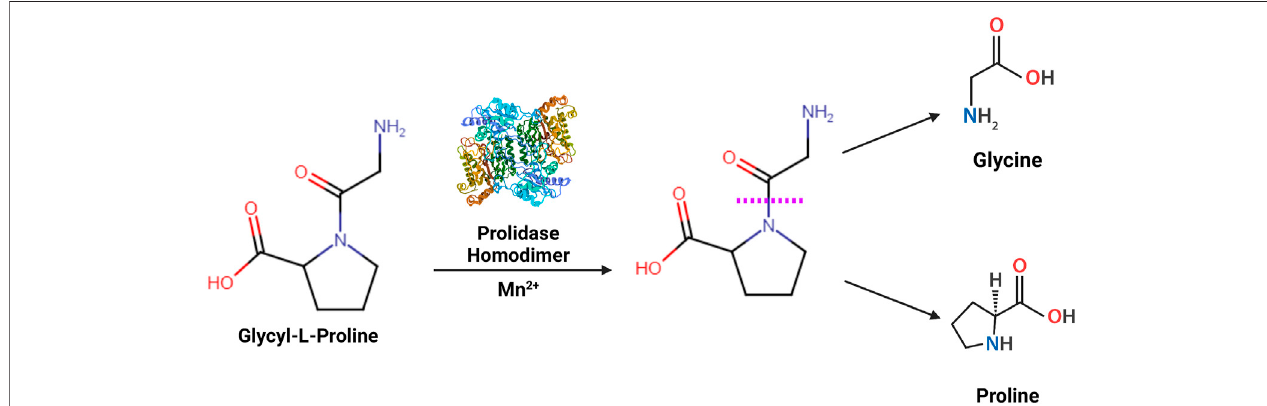
FIGURE1 | Enzymatic reaction catalyzed byprolidase- Prolidase isametallopeptidase that functions asahomodimer catalyzing thehydrolysis ofimidodipeptides containing a C-terminal proline or hydroxyproline residue (Xaa-Pro). The scissile amide linkage hydrolyzed by prolidase is shown with a purple dashed